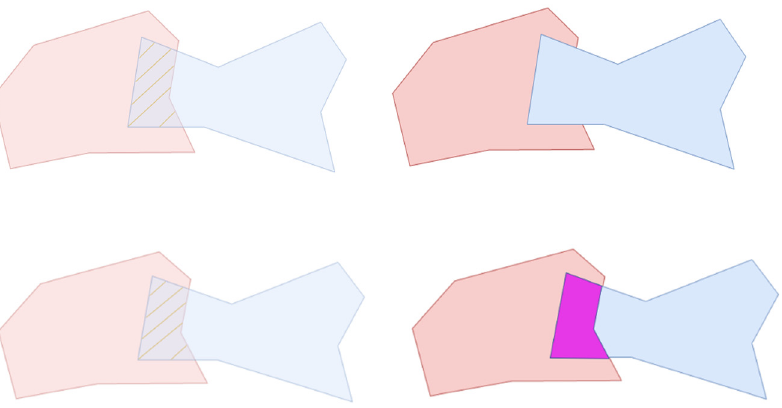
Figure 2. Deconfliction process representation. Top : a remove/restore decision where the blue survey uptakes the red one; Bottom : a supplement decision where both surveys are merged.